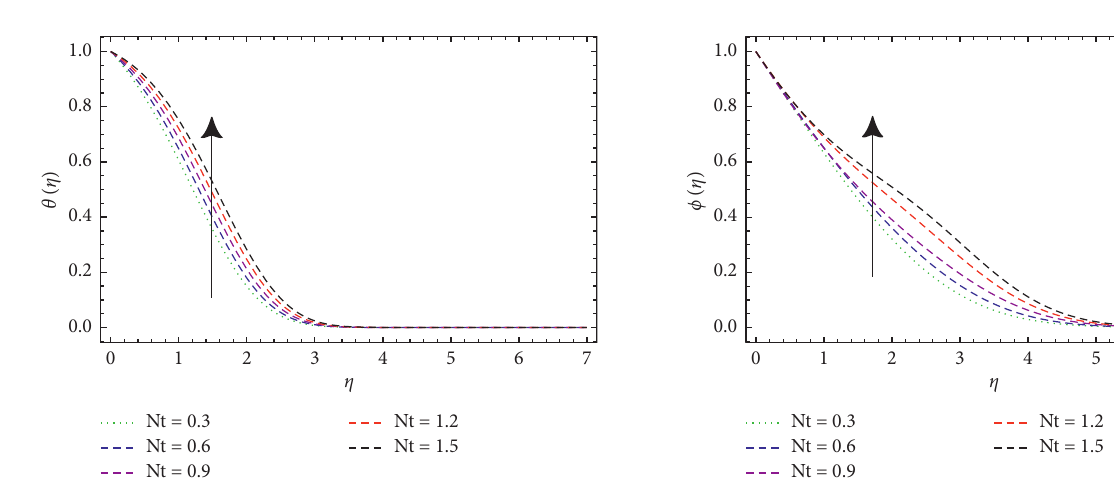
Figure 11: Influence of the temperature θ ( η ) profile via Nt.